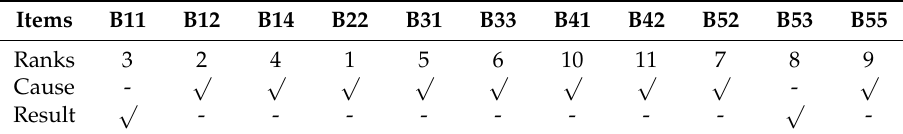
Table 14. Ranks and attributes of the key financial barriers.